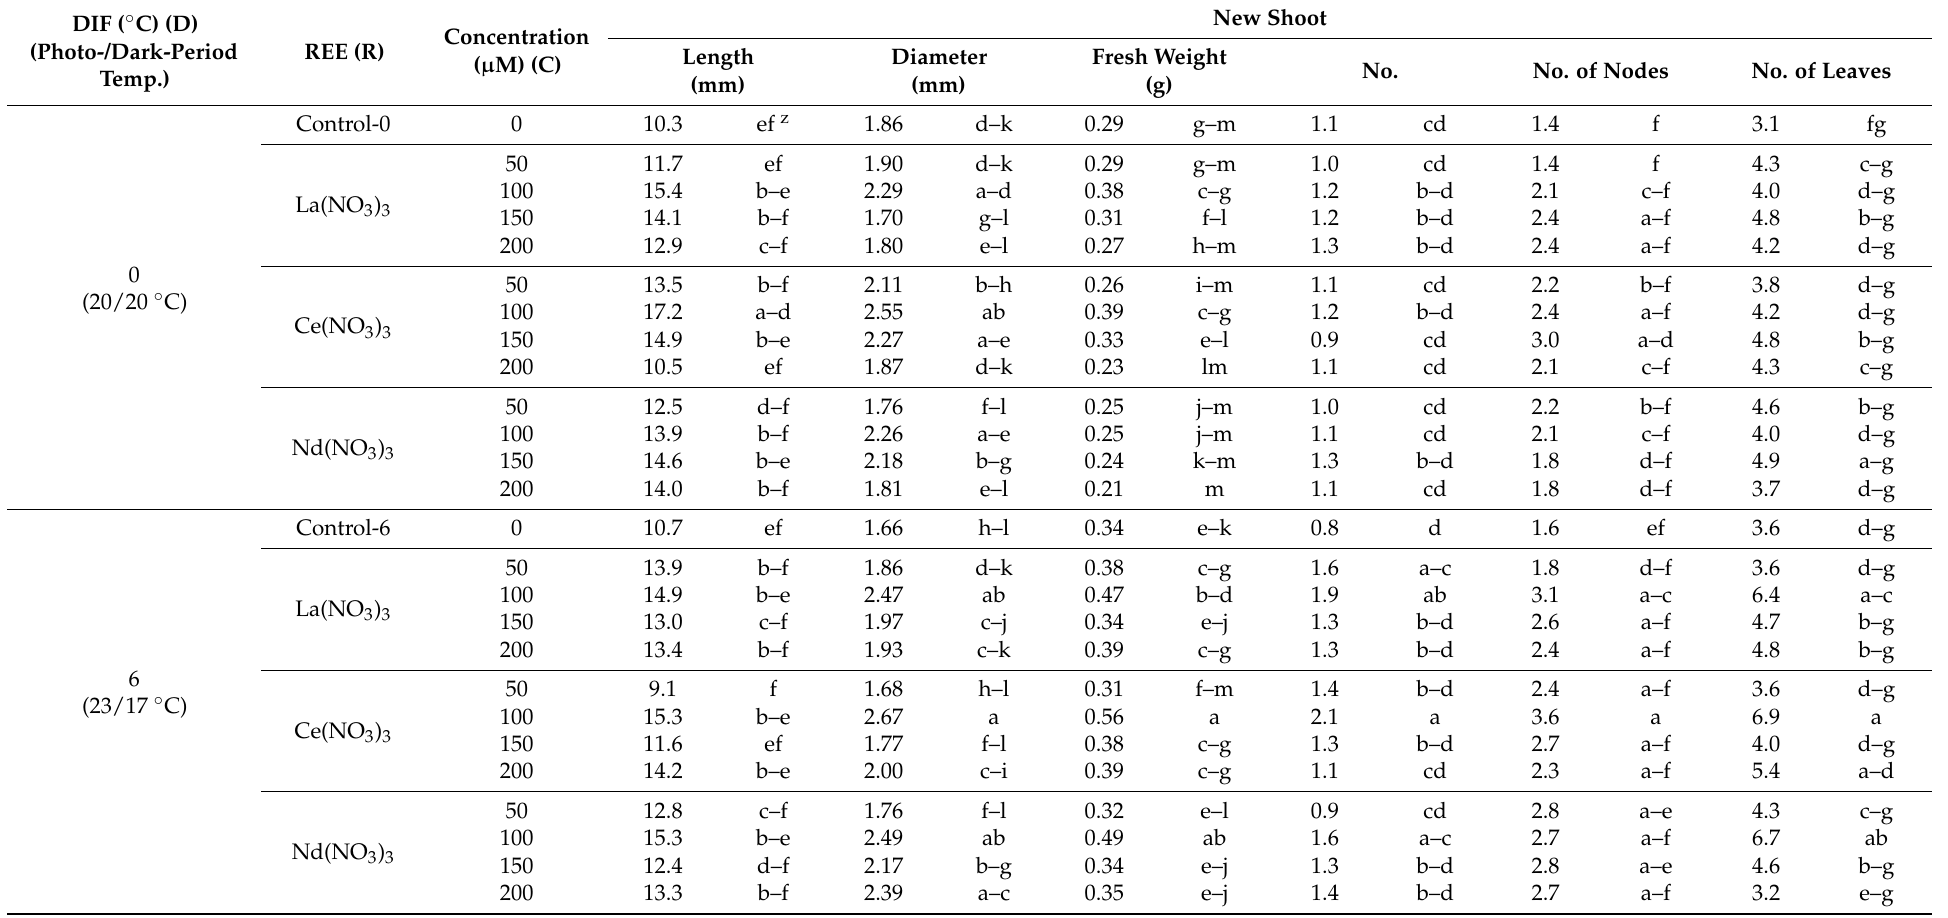
Table 1. Effect of the DIF and REE supplementation on growth and development of D. aphyllum